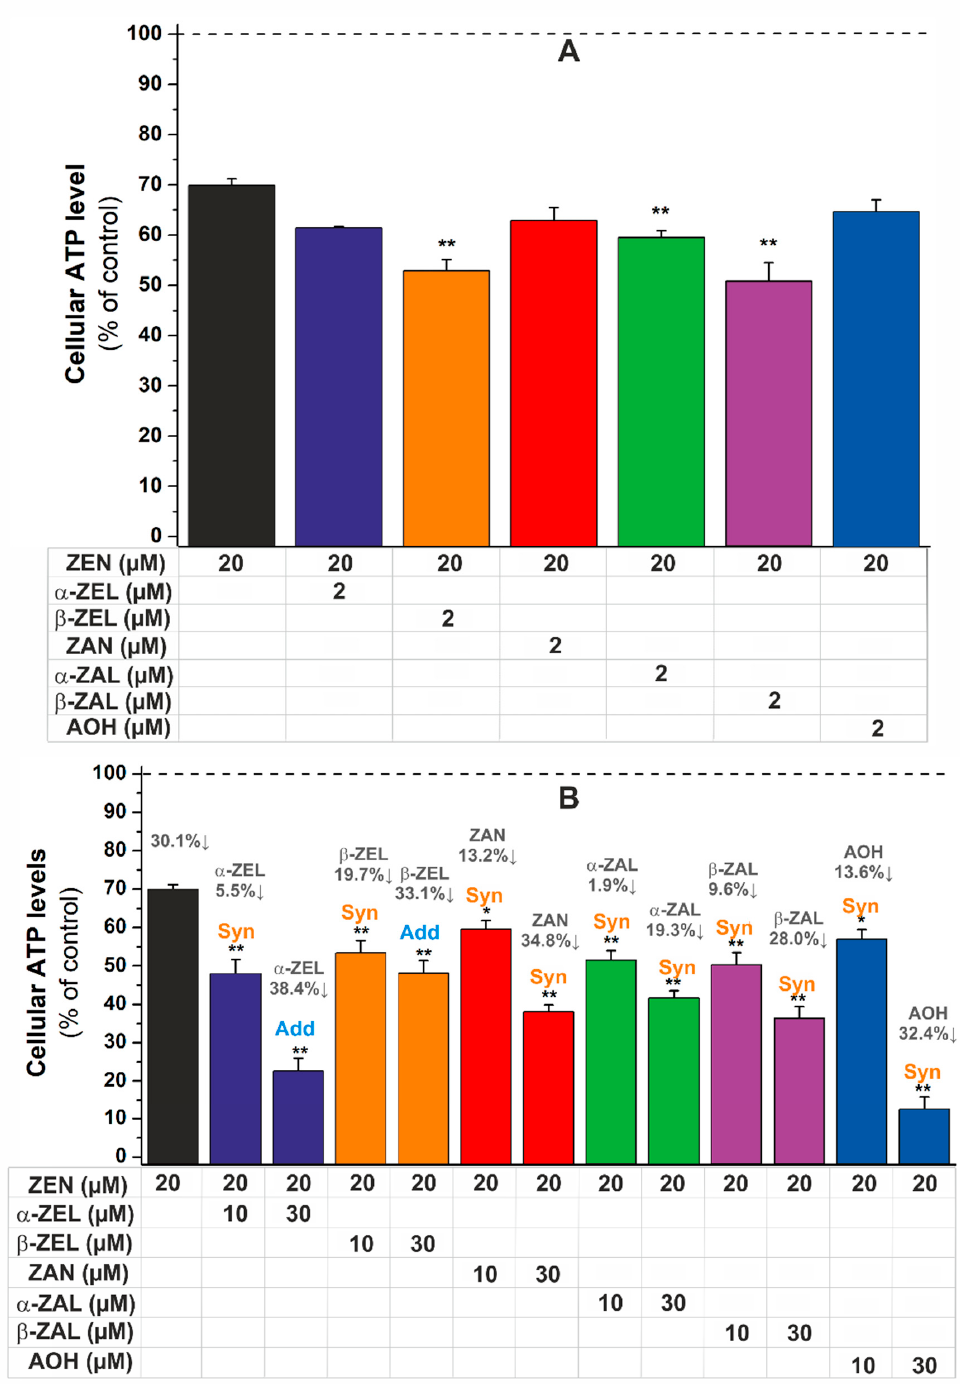
Figure 3. The effects of ZEN alone and in combination with the subtoxic ( A ) or toxic ( B ) concentrations of α -ZEL, β -ZEL, ZAN, α -ZAL, β -ZAL, and AOH on HeLa cells after 24 h incubation (ATP/well, % of control; changes compared to the ZEN-exposed cells: * p < 0.05 and ** p < 0.01). The individual effects of mycotoxins at the concentrations applied are demonstrated with dark grey color ( B ).